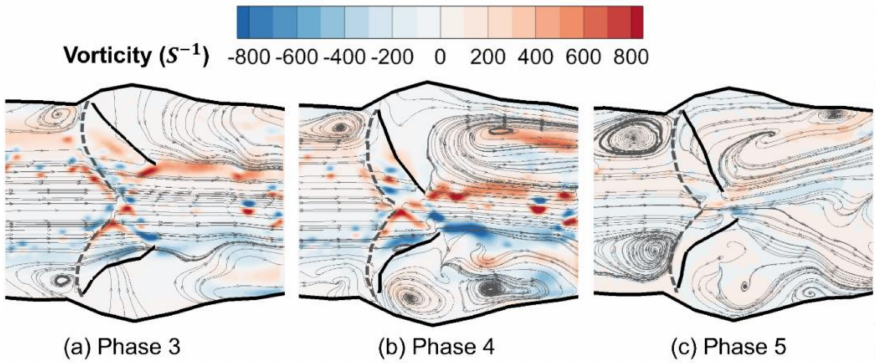
Figure 6. Out-of-plane vorticity fields at selected